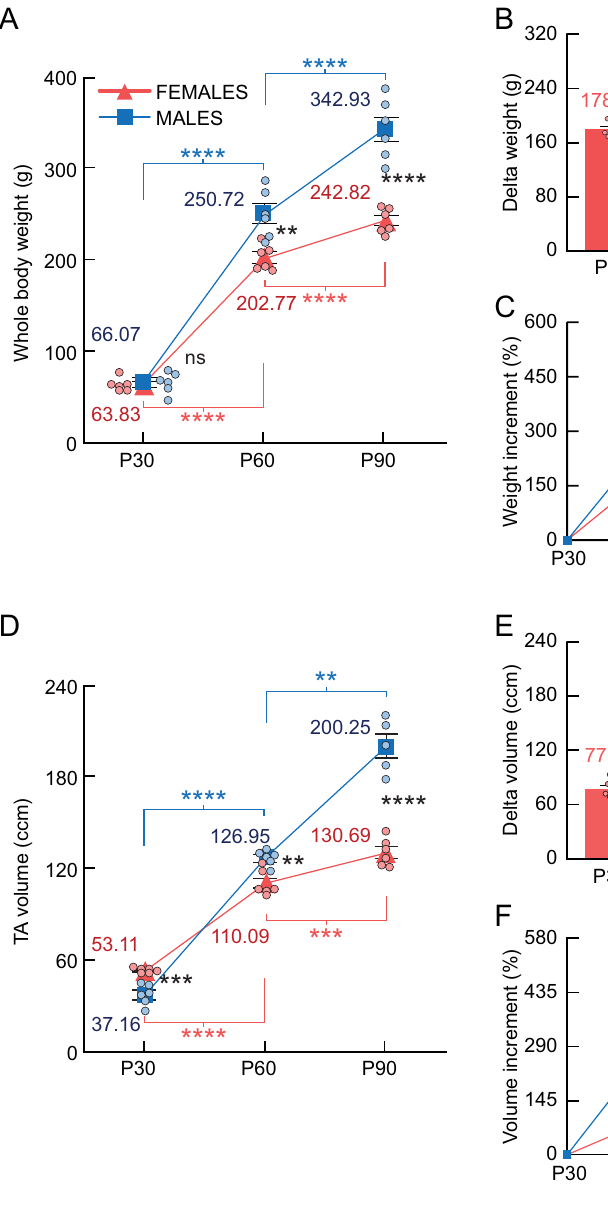
Figure 3. Body weight and thoracoabdominal (TA) volume of female (red) and male (blue) rats. ( A ) Raw whole-body weight (g) on P30, P60 and P90. The split-plot ANOVA revealed an interaction between age and sex (F 1.3,20 = 89.70, p < .01), with a main effect of age (F 1.3,13.2 = 1978.56, p < .01) and sex (F 1,10 = 25.79, p < .01) in body weight. ( B , B’ and B” ) Delta weight (g) from P30 to P90, P30 to P60 and P60 to P90. ( C , C’ and C” ) Percentual increment of body weight (%) from P30 to P90, P30 to P60 and P60 to P90. ( D ) TA volume (ccm). The split-plot ANOVA revealed an interaction between age and sex (F 2,20 = 104.48, p < .01), with a main effect of age (F 2,20 = 820.84, p < .01) and sex (F 1,10 = 40.47, p < .01) in TA volume. ( E , E’ and E” ) Delta TA volume (ccm). ( F , F’ and F” ) Percentual increment of TA volume (%). Statistics : Between-subjects effects were followed with Fisher’s LSD post-hoc. Paired T-test was used for within-subjects comparisons. Unpaired T-test was used in delta and increment between-subjects comparisons. Black stars (*): female versus male. Blue symbols: within- male comparisons. Red symbols: within-female comparisons. Values represented as mean and SEM. Significance levels: * p < .05, ** p < .01, *** p < .001, **** p < .0001, ns: p > (Fig. 4I’,I”). Note that the delta VAT% values of the adolescence and young adulthood were similar in both females and males (Fig. 4H’,H”) (see discussion). In relation to the SAT%:VAT% ratio, females showed a higher ratio on P30, but lower than males on P60 and P90 (Fig. 4J). Finally, females showed lower VAT% than SAT% on P30, but higher VAT% than SAT% on P60 and P90 (Fig. 4K–K”). On the other hand, males showed higher VAT% than SAT% on P90 only (Fig. 4L–L”).